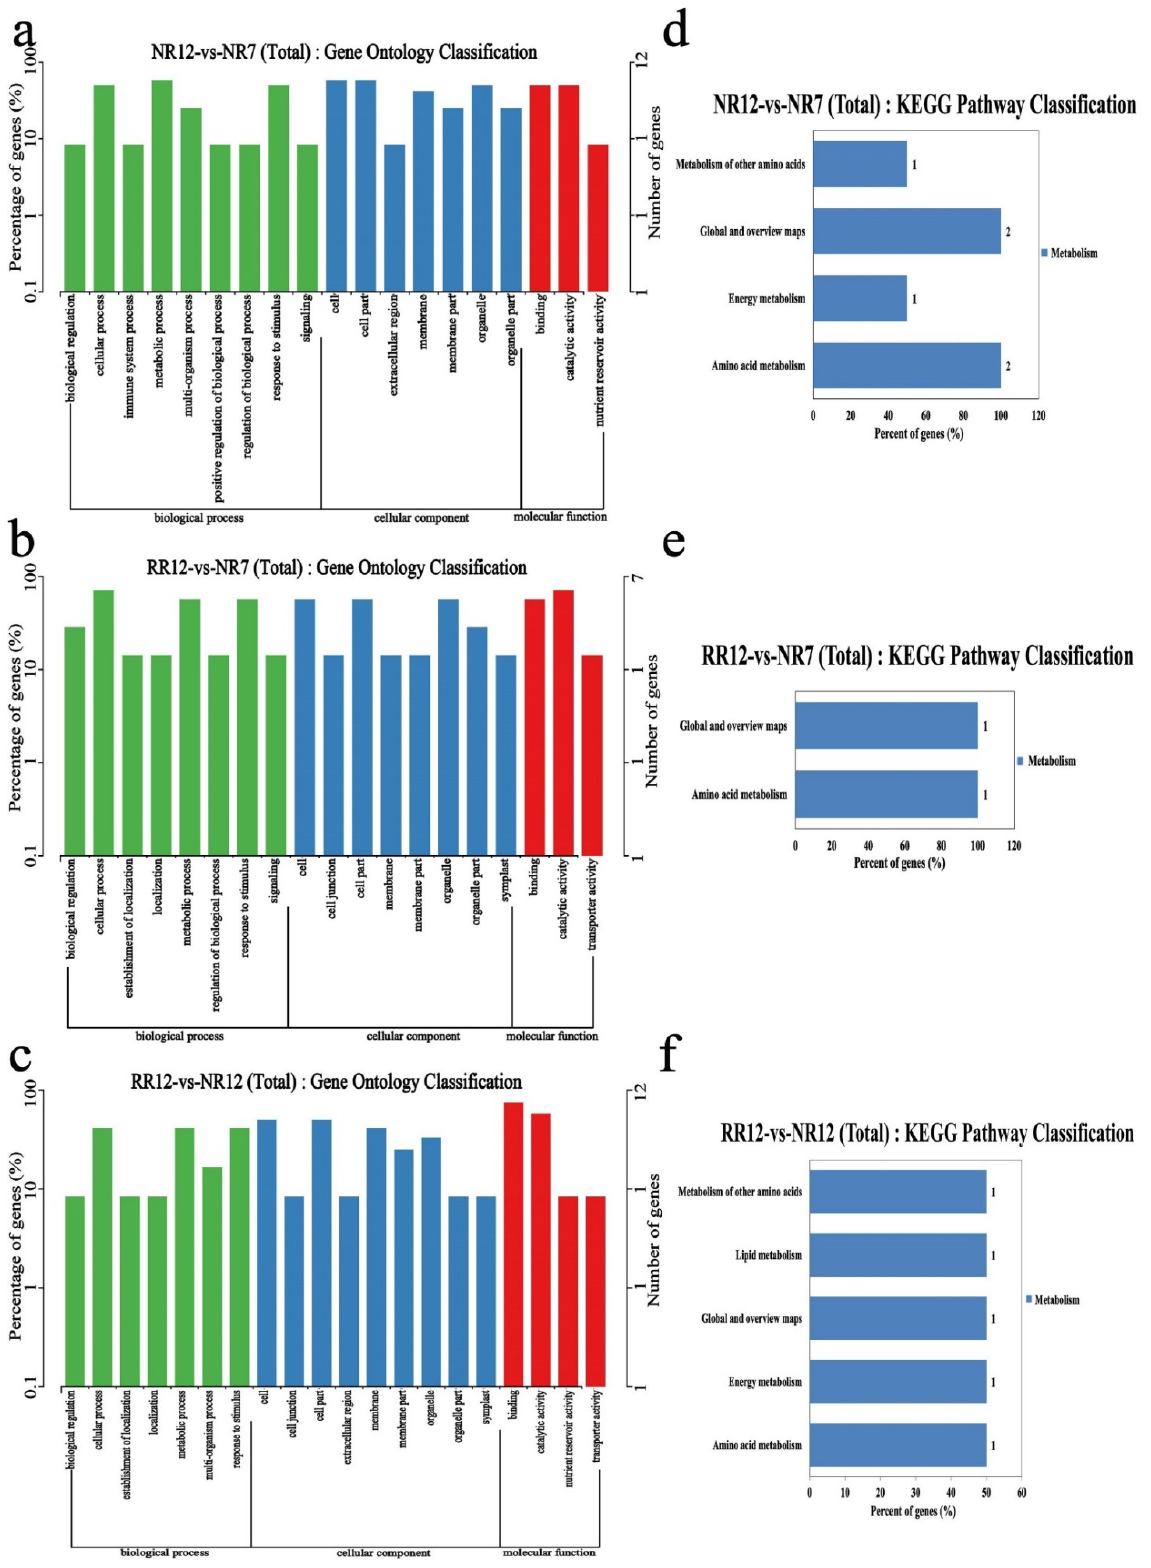
Figure 8. The functional analysis results of host genes of differentially expressed circRNAs. GO enrichment ( a – c ) and KEGG pathway ( d – f ) in NR12_vs_NR7, RR12_vs_NR7, RR12_vs_NR12.